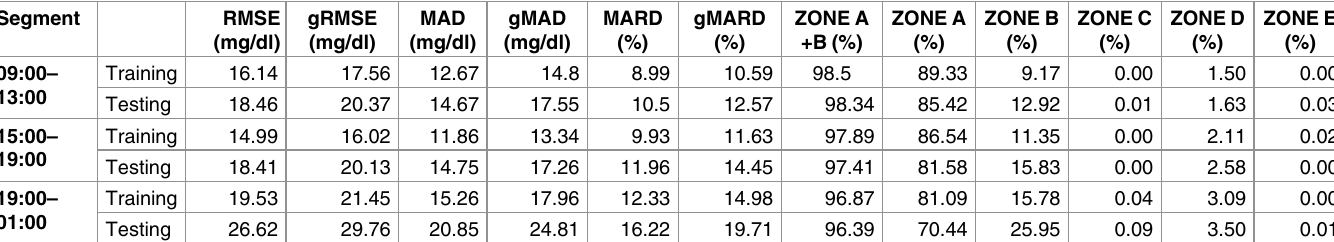
Table 3. Mean values of the performance metricsfor 100 patients fitting 4-h prediction models.